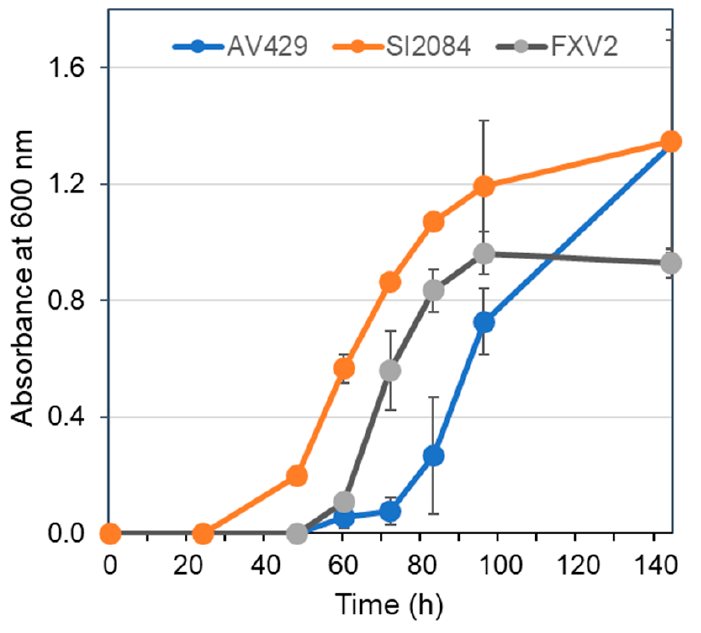
Figure 2. Growth curves of strains G. entanii AV429, G. entanii SI2084 and G. entanii FXV2 in medium AE containing 4 vol% of acetic acid and 3 vol% of ethanol.